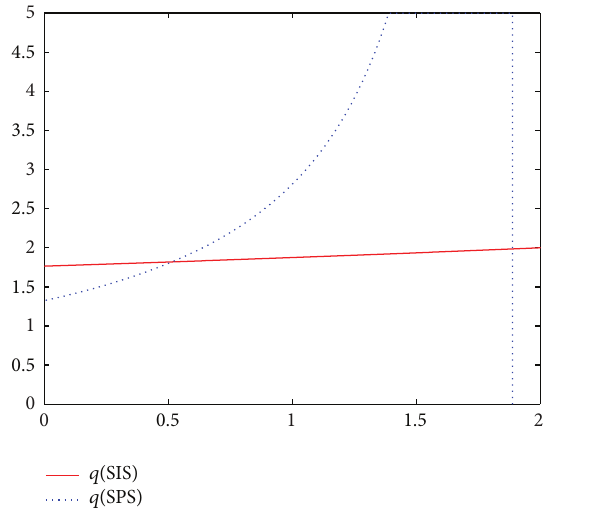
Figure 5: Equilibrium social welfares.